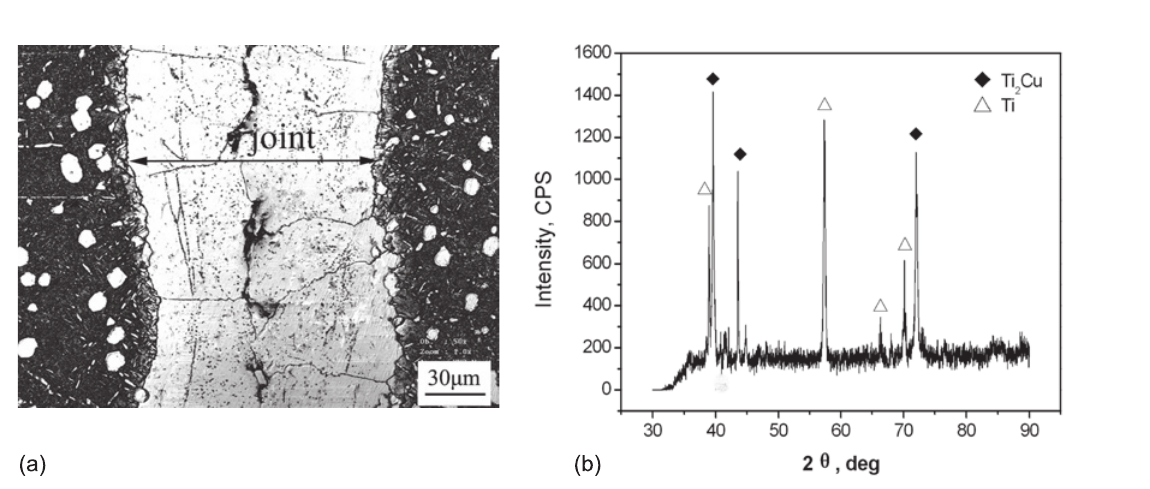
Fig. 5: Joint produced at 950 °C × 60 min. a: joint microstructure, b: XRD pattern taken from the fracture surface of the joint